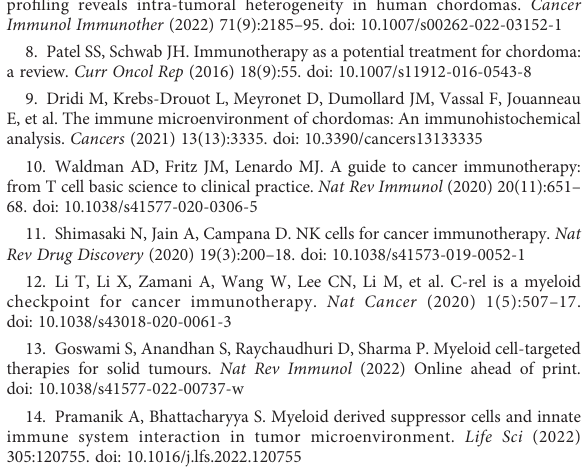
SUPPLEMENTARY FIGURE 4 Representative density heat maps of pan macrophages, monocytes, PMNs, CD4 + T cells, CD8 + T cells, T regs , and NK cells in fi ltrating a chordoma specimen. A large proportion of myeloid cells, T cells, and NKcellsareconcentratedalongthesuperiorandlefttumorborders.Many myeloid cells also in fi ltrate its center. PMNs, polymorphonuclear cells; NK cells, natural killer cells. SUPPLEMENTARY FIGURE 5 Chordoma myeloid, T cell, and NK cell density does not signi fi cantly differ by age. Immune in fi ltrate differences between chordoma patients ≤ 35 years old and >35 years old (n=20) were assessed with a Mann Whitney test using a p value threshold of <0.05. ns, non signi fi cant.NK cell, natural killer cell. SUPPLEMENTARY FIGURE 6 HALO ® spatial proximity analyses of immune cells to chordoma cells demonstrate that T cells are nearer than myeloid cells to tumor cells. (A) Sacral chordoma specimen with three categories of T cells, CD4 + T cells, CD8 + T cells, and T regs shown in blue, yellow, and red respectively. Tumor cells are shown in green. A segment of heavy T cell in fi ltrate is magni fi ed. (B) Real time proximity analysis between CD4 + T cells (green, Opal 520) and chordoma cells (white, Opal 780) with bars measuring distance between these superimposed on the image in white. (C) Proximity line series between T cells and chordoma tumor cells. (D) Proximity analysis histograms of myeloid cells (top row, red) and T cells (bottom row, blue) to chordoma tumor cells within a 100µm radius by progressive segments of 20µm bands (n=56 individual tumors). Histogram y axes have been standardized for the direct comparison of immune cell phenotype